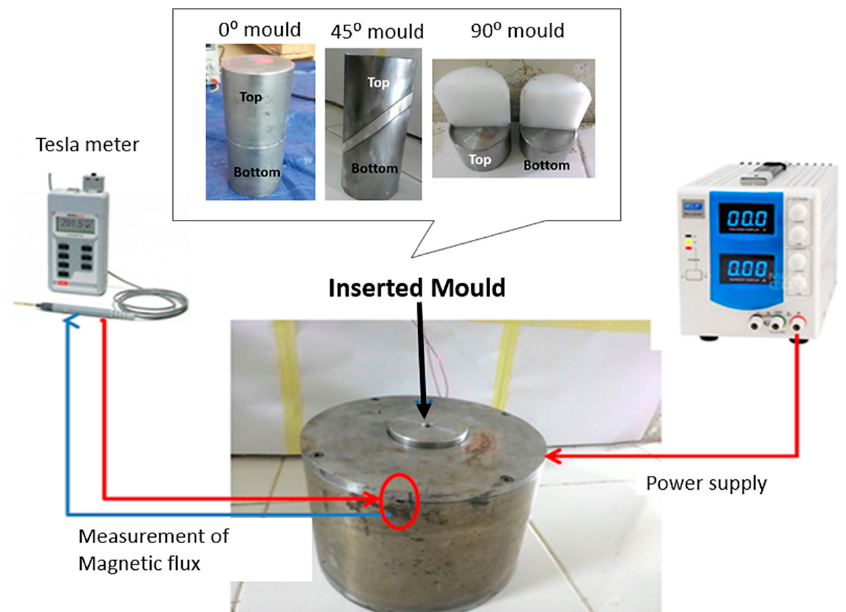
Figure 4. The setup of a curing device for anisotropic MRE with various mold orientations was inserted.